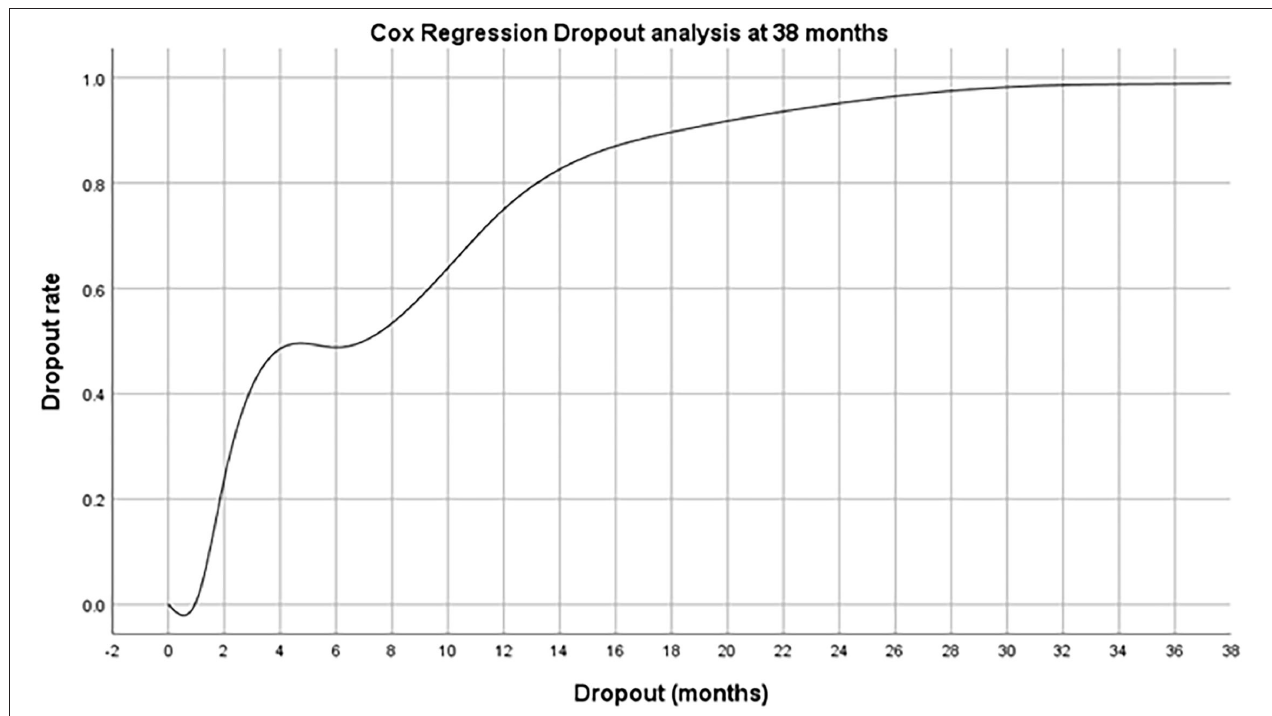
FIGURE 1 | Cox regression dropout survival analysis at 38 months after